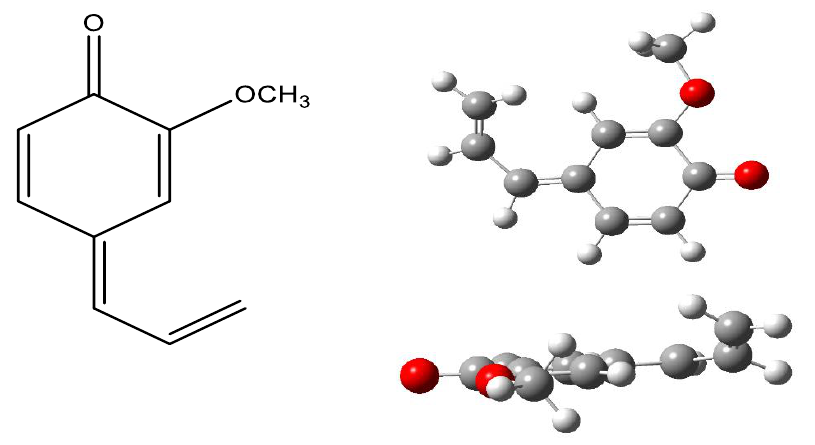
Figure 2. Derived quinone from Eug after the donation of two hydrogen atoms following a step-wise hydrogen atom transfer (gas phase at B3LYP/6-31G).